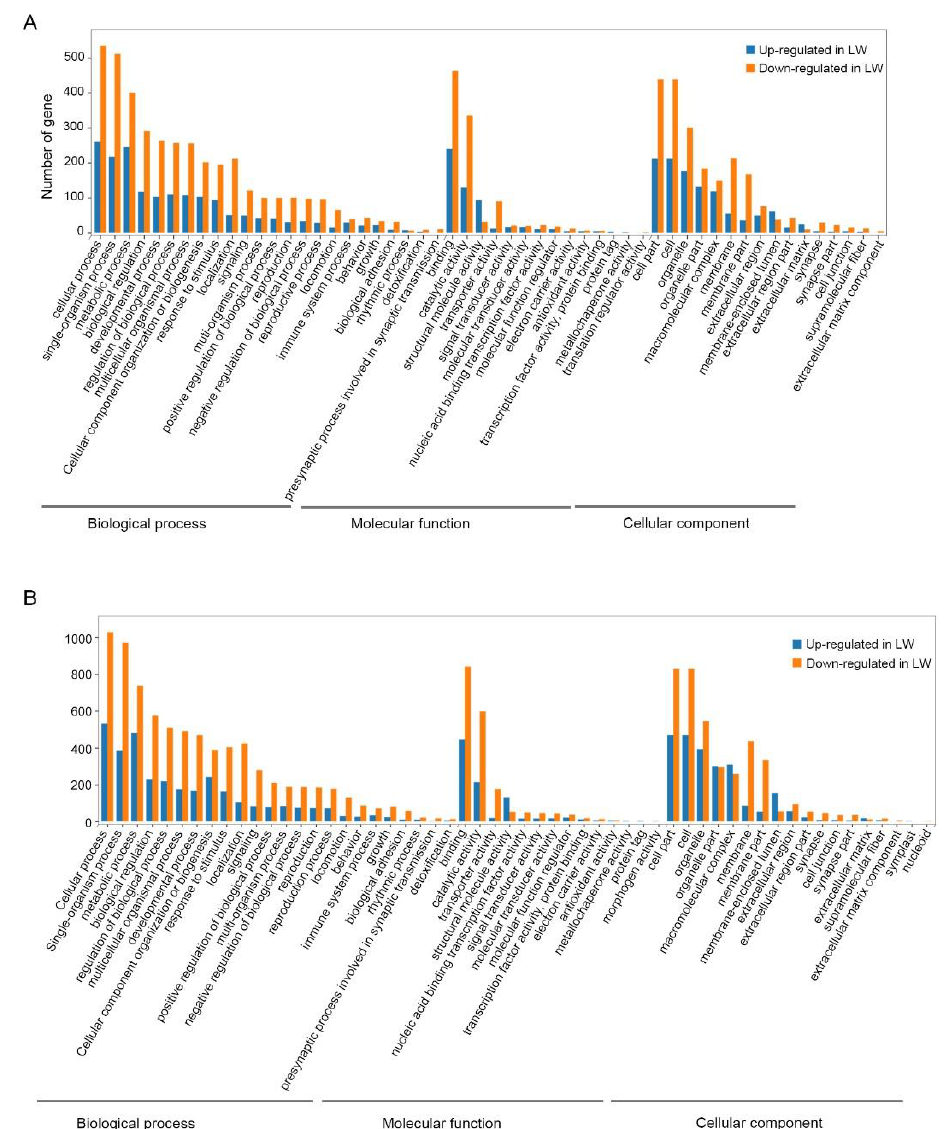
Figure 2. Gene Ontology (GO) classification of differentially expressed genes in forewing ( A ) and hindwing ( B ) buds of 24 hAE-5th-instar nymphs with NlFoxO and Gfp knockdown. GO analysis is summarized as three main categories: cellular component (CC), molecular function (MF), and biological process (BP).